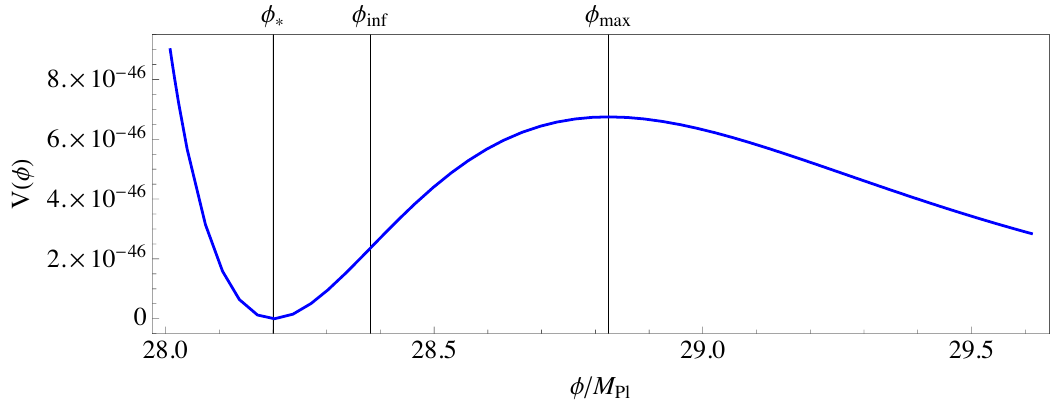
Figure 16 . The scalar potential in the LVS as a function of the canonically normalised volume modulus (cid:30) for (cid:30) (cid:3) ’ 28 : 2 M Pl . In string units, the value of the volume in the minimum is V min = 10 15 . The solid black lines denote the value of the canonically normalised volume modulus at the minimum of the potential (cid:30) (cid:3) , at the in(cid:13)ection point of the potential (cid:30) inf , and at the local maximum of the potential (cid:30) max .